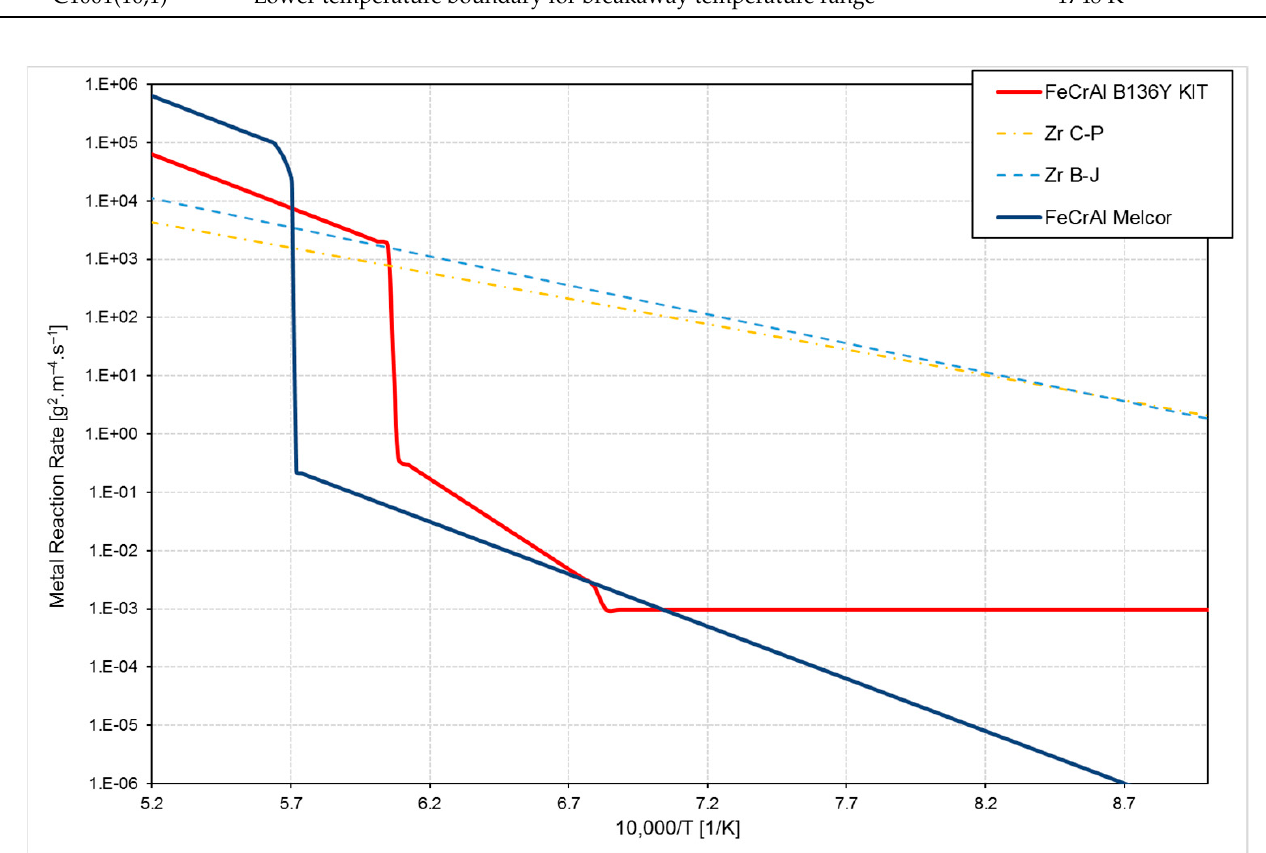
Figure 6. Metal reaction rates for cladding alloys. FeCrAl MELCOR corresponds to the parameters shown in Table 3. FeCrAl B136Y KIT is the reaction rate recently measured by KIT [14], and C-P and B-J are well-known correlations for Zr [15,16].